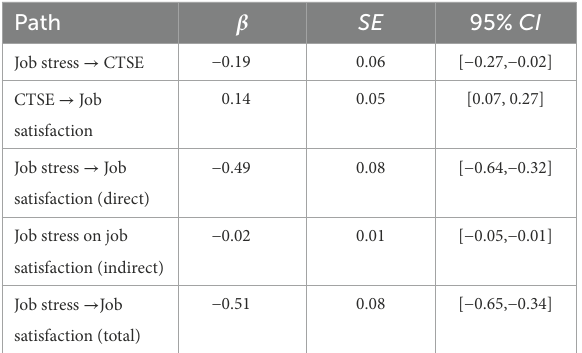
TABLE 1 Effects of job stress on job satisfaction by college teaching